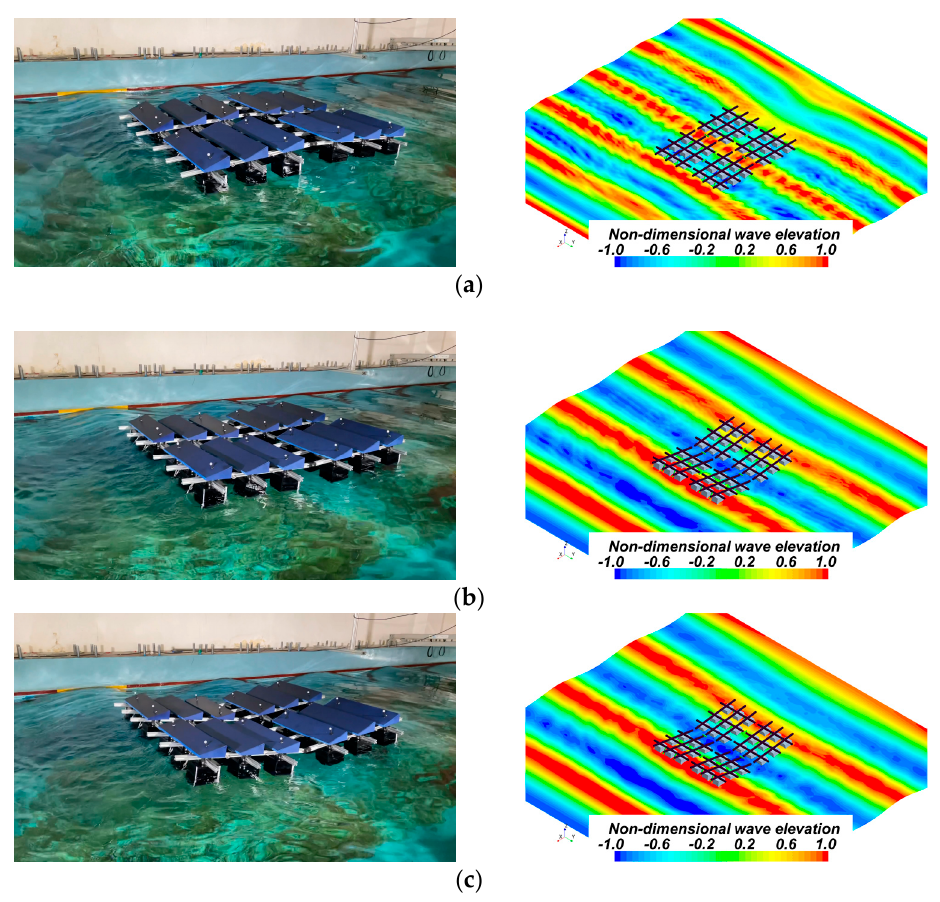
Figure 21. Wave pattern of experiment (left) and computation (right) according to the wavelength for H / λ = 0.05 under head sea: ( a ) λ / L unit = 1.6; ( b ) λ / L unit = 2.0; ( c ) λ / L unit = 2.4.